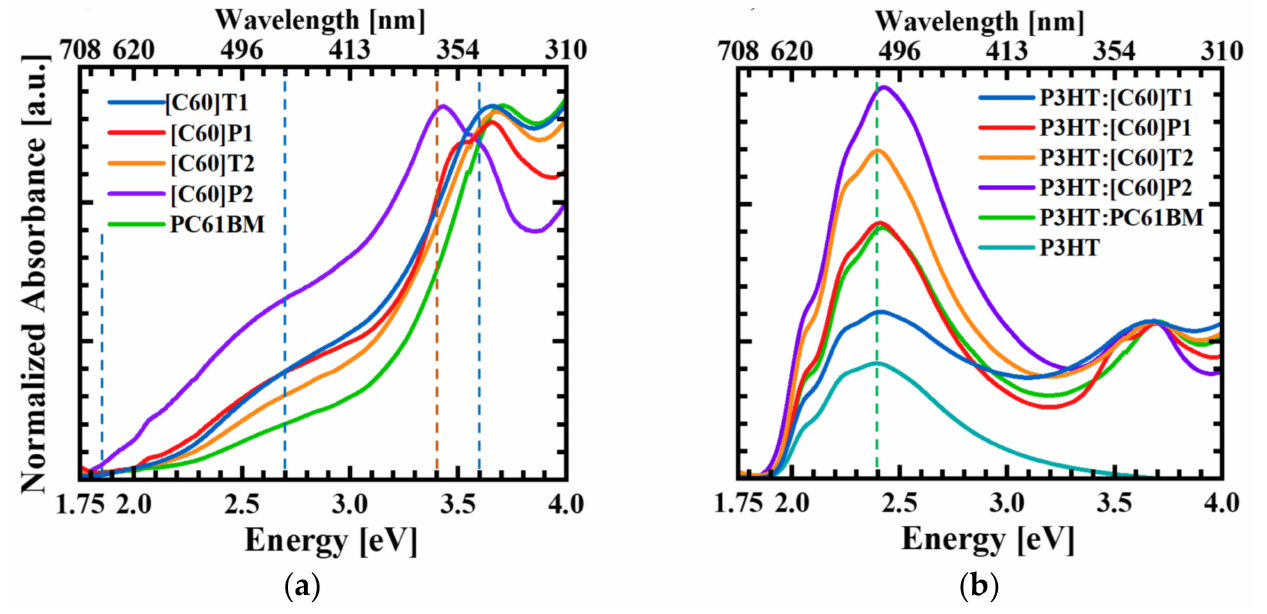
Figure 3. Absorption spectra of ( a ) fullerene derivatives and ( b ) their blends with P3HT. The dashed lines mark the respective transitions: the intra-pyrene transition is marked with the orange line, fullerene transitions are marked with the dark blue lines and P3HT maximum absorption with the green